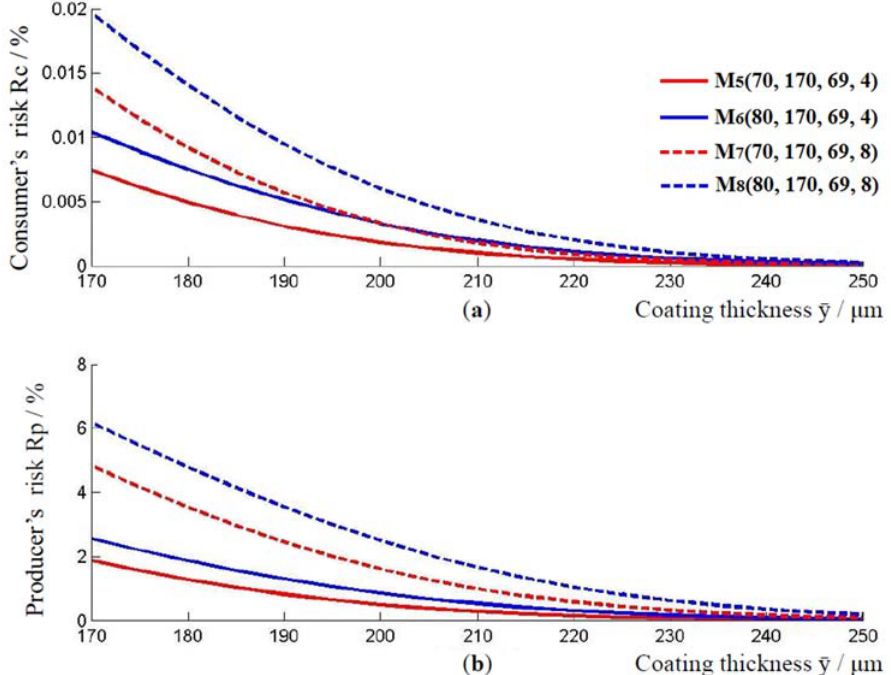
Figure 5. Relationship between the applied thickness of the coating and the consumer’s and producer’s risk. ( a ) Change in consumer risk with increasing coating thickness, and ( b ) change in consumer risk with increasing coating thickness, for models M 5 , M 6 , M 7 and M 8 .